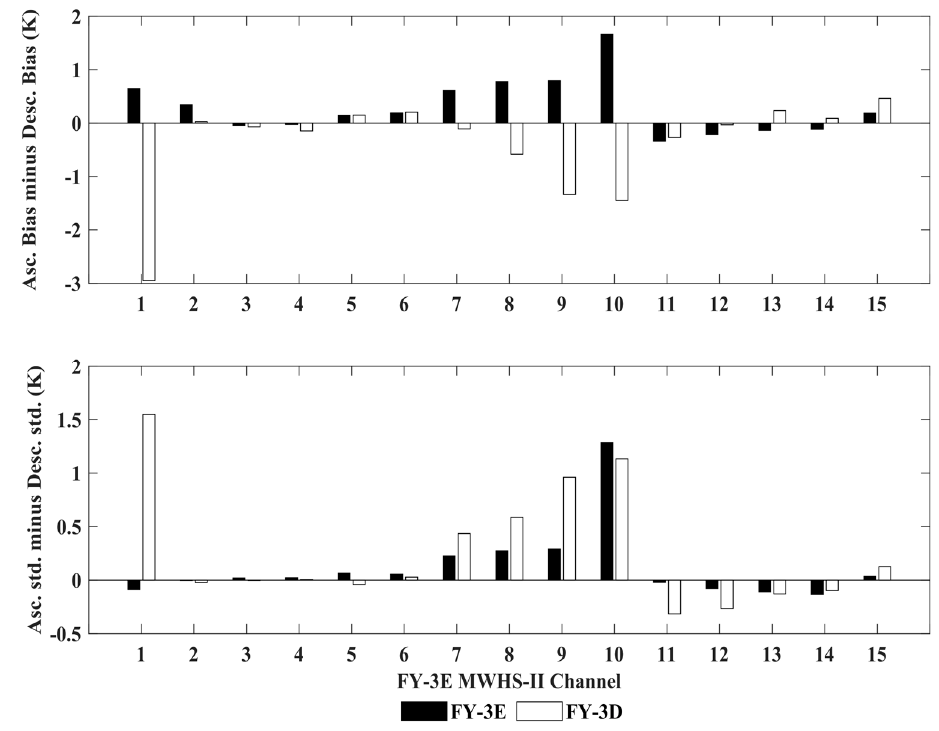
Figure 7. The same as Figure 6, but for FY-3E MWHS-II (black) and FY-3D MWHS-II (white). x- coordinate is the channel number of FY-3E MWHS-II.